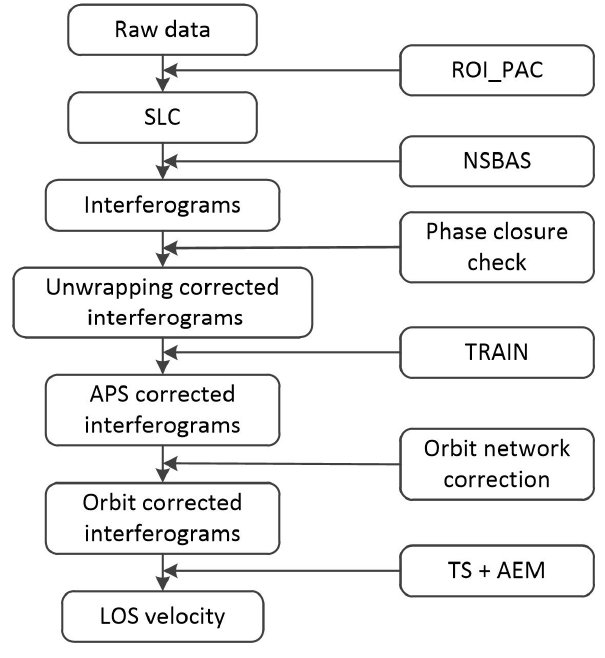
Figure 4. Flow chart of data processing, from raw data to final LOS velocity.